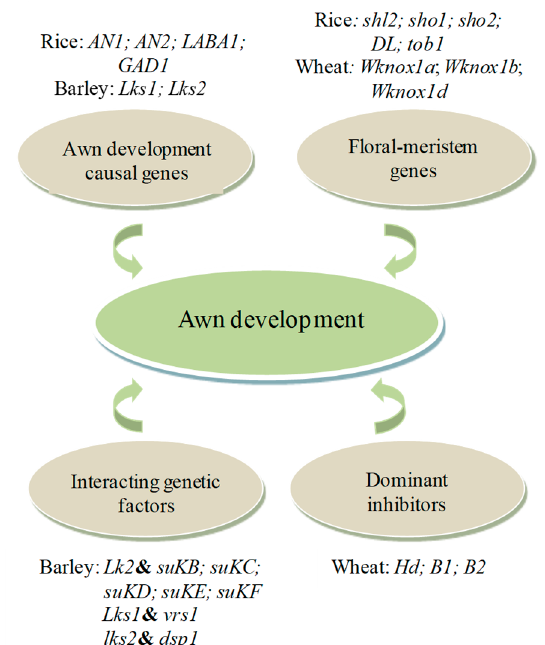
Figure 3. An overview of genetic factors underlying awn development in major cereal crops. The sketch shows major loci that control the initiation and elongation of the awn in rice, wheat, and barley, along with several genes that rely on mutual effects with other genes to promote awn growth. It also shows loci that reduce awn length or inhibit awn development. Both gene expression and interactions between genetic factors play an integral role during awn development and have a wide variety of pleiotropic phenotypic effects. The ampersand symbols stand for interactions between/among genetic factors.